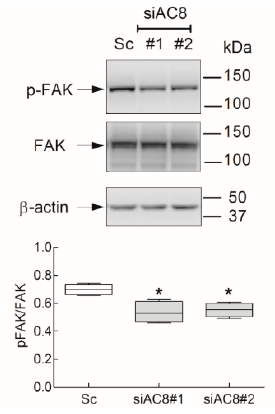
Figure 10. Role of AC8 in focal adhesion kinase (FAK) tyrosine phosphorylation in MDA-MB-231 cells. MDA-MB-231 cells were transfected with siAC8#1, siAC8#2, or scramble plasmid (Sc), as indicated. Forty-eight hours later, cells were lysed and subjected to 10% SDS-PAGE and Western blotting with anti-phospho-FAK (Y 397 ) or anti-FAK specific antibodies. Membranes were reprobed with anti- β -actin antibody for protein loading control. Blots are representative of five separate experiments. The box plot represents FAK tyrosine phosphorylation presented as the phospho-FAK / total FAK ratio.